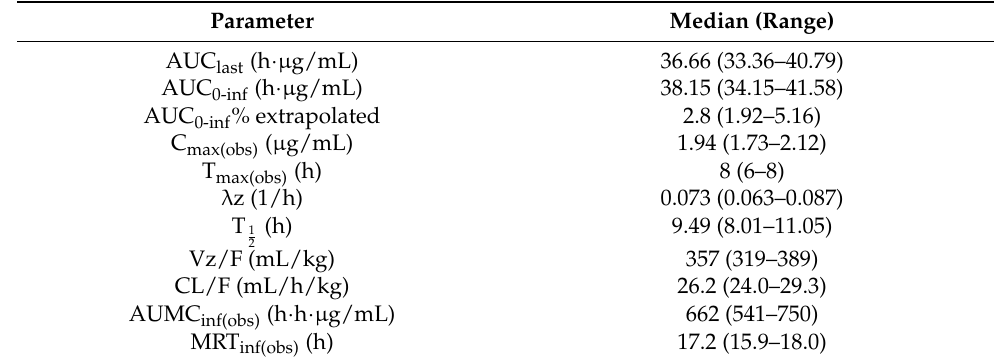
Table 2. Median (range) for non-compartmental pharmacokinetic parameters estimated for sheep (n = 6) administered a single oral 1 mg/kg dose of meloxicam.